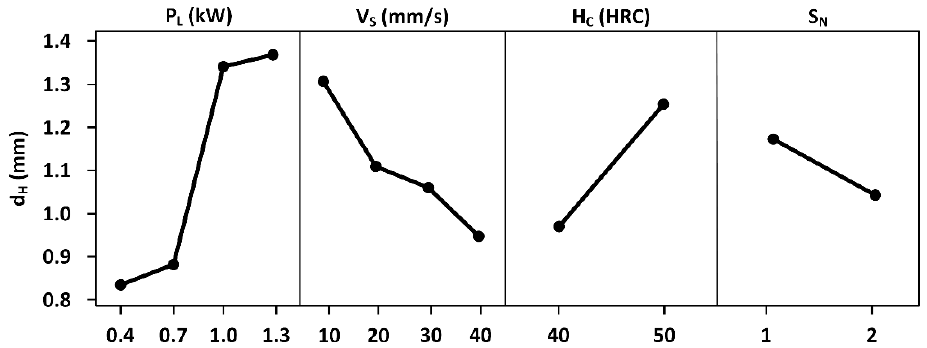
Figure 3. Parameter effects (including surface roughness R a ) on d H .